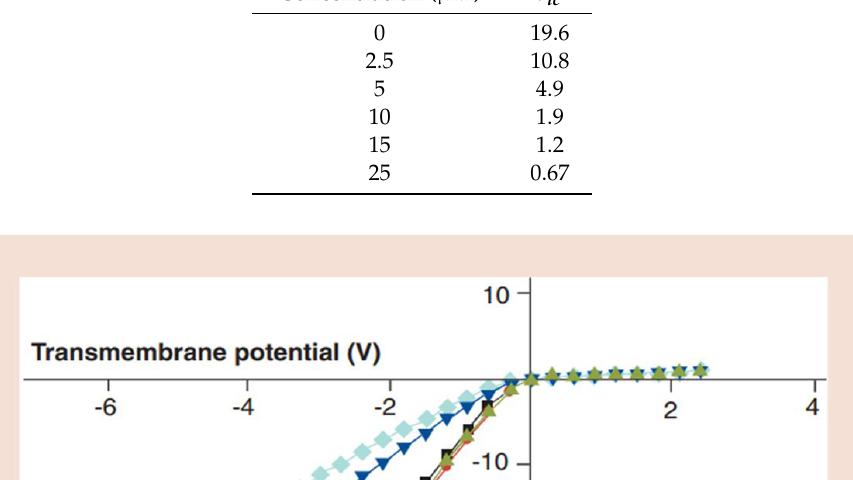
Table 1. Ion-current rectification (ICR) rectification ratios as a function of Hoechst 33258 concentration. Reprinted and adapted with permission from [26]. Copyright 2008, Future Medicine.